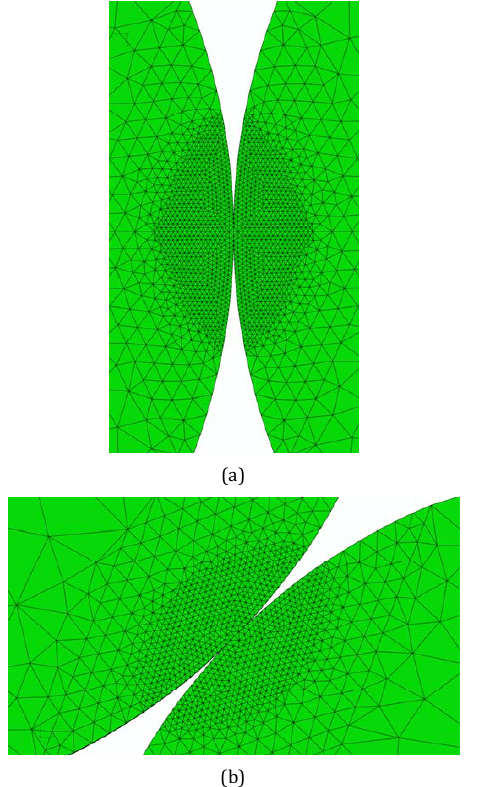
Figure 7. Contact zone refined mesh for (a) the QS and (b) BCC models.